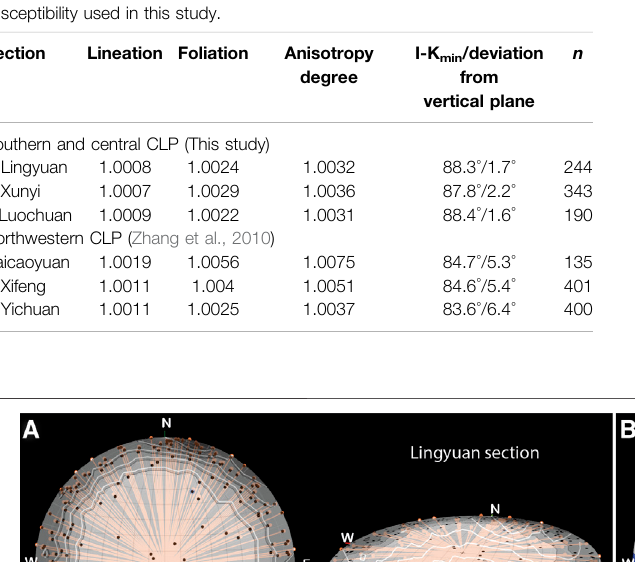
Frontiers in Earth Science |